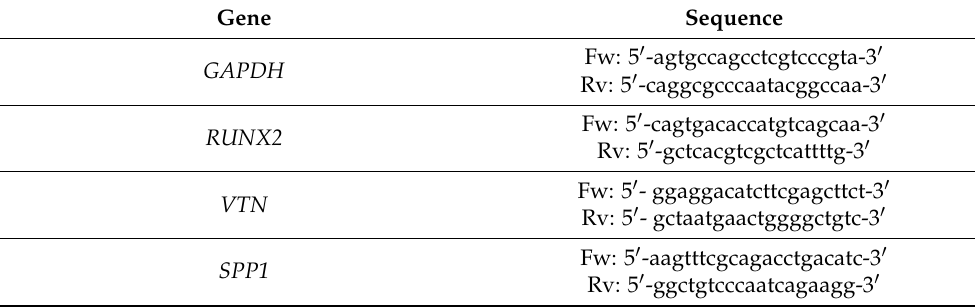
Table 1. Oligonucleotides sequences of the genes evaluated by quantitative PCR. Gene Sequence